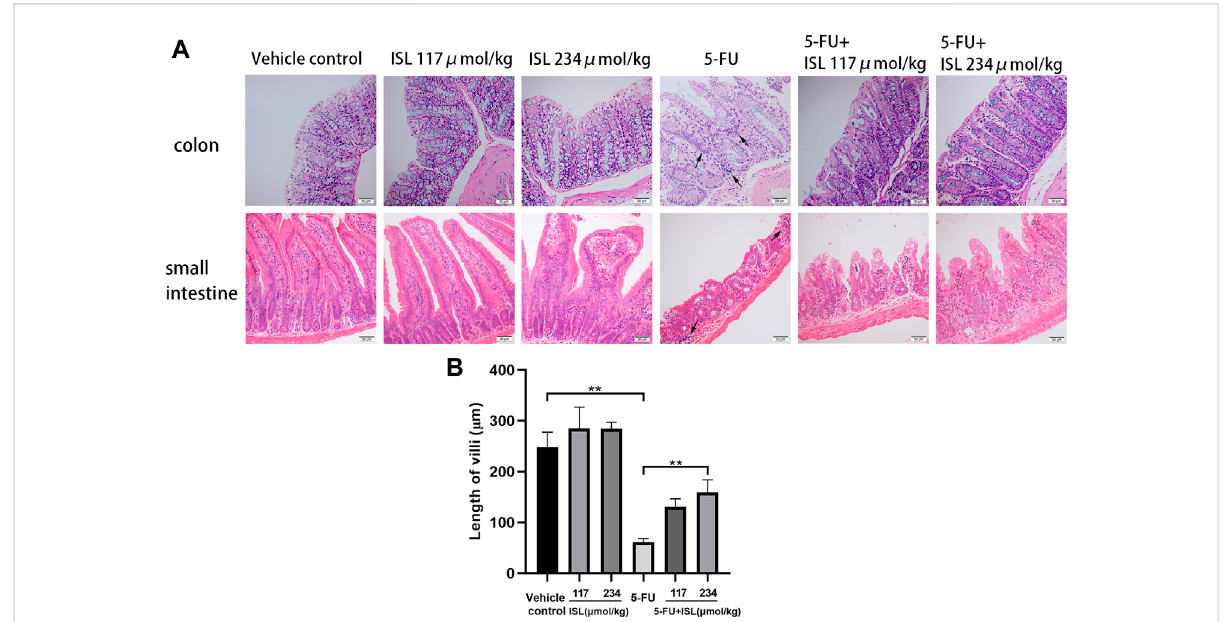
FIGURE 7 EffectofISLonintestinalhistopathologicaldamageinmice. (A) Hematoxylinandeosin(H&E)stainingofsmallintestineandcolon.Allimagesare displayedat×200magni fi cation.In fl ammatorycellin fi ltration(blackarrows)isobservedinthe5-FUgroup. (B) Lengthofsmallintestinalvilli.Dataare presented as mean ± S.D. (n = 3 in each group). ** p <